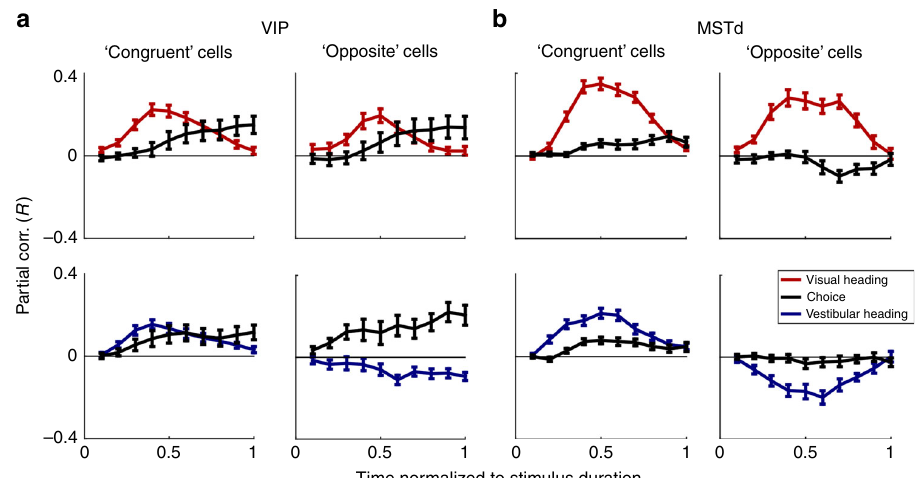
Fig. 6 Partial correlation time-course for congruent and opposite cells. Average partial correlation ( R ) values are presented for congruent and opposite cells in VIP ( a ) and MSTd ( b ). Here, the data were aligned to each cell ’ s visual heading preference by inverting the partial correlation signs such that the visual heading partial correlation was always positive. This was done together for visual and vestibular heading and choice partial correlations, such that positive choice (or positive vestibular heading) R -values indicate responses with the same sign as the visual heading partial correlation. Cell selection and N values are the same as in Fig. 5. The old and new data were pooled in this plot, and the times along the horizontal axis are normalized to stimulus duration. All error bars denote